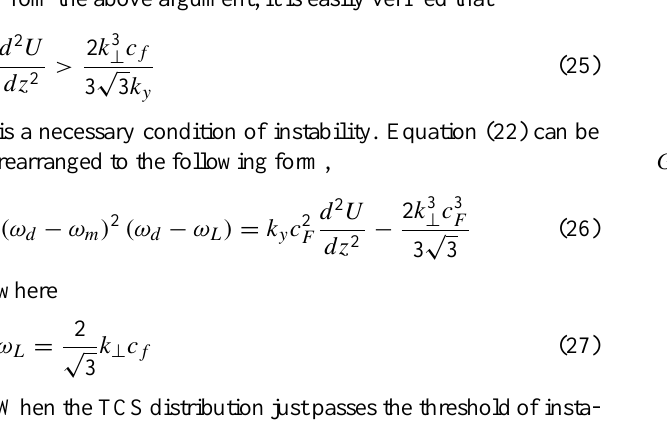
Fig. 1. Diagram showing the development of instability. G(ω) is the function given in Eq. (28). The figures shows the change of the solution to G(ω) = C . When C is sufficiently large (dashed line), there is a pair of complex solution, one of which is